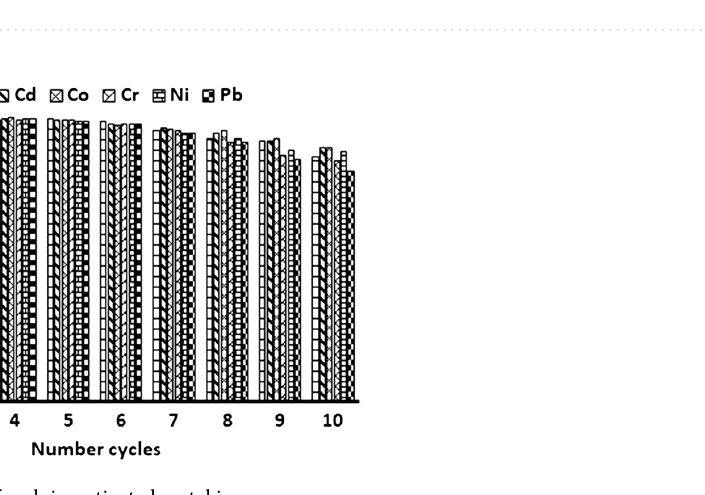
Table 7. Analytical characteristics of UA-DSPME/ICP-OES in comparison with other methods in the literature.